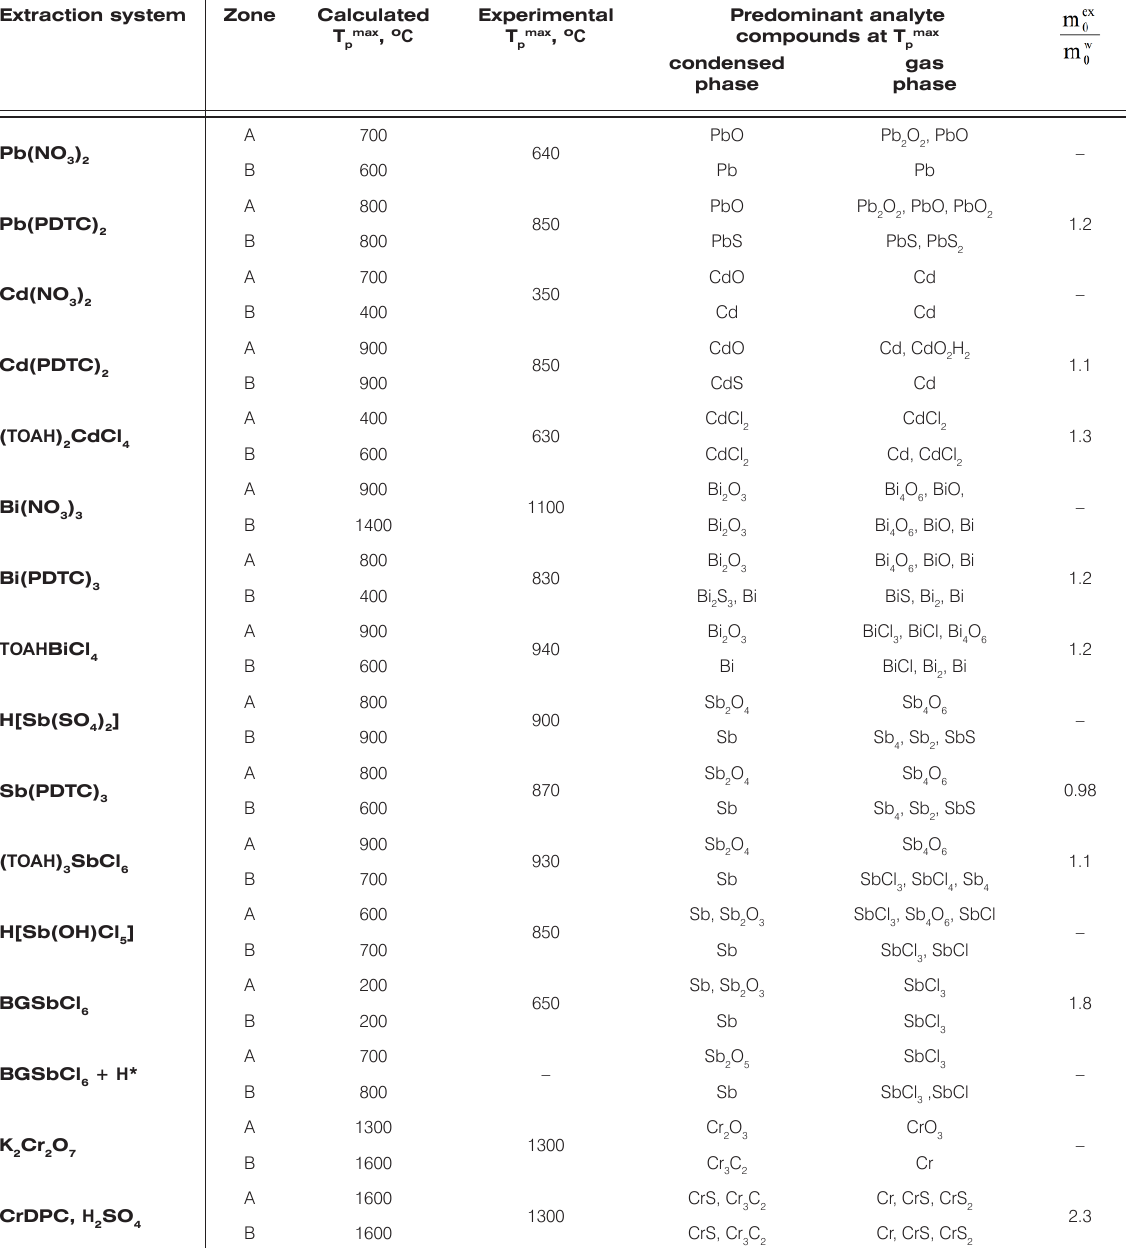
Table 3. Thermochemical processes thermodynamic modeling , and experimental values of relative sensitivity and maximum pyrolysis temperature. Extraction